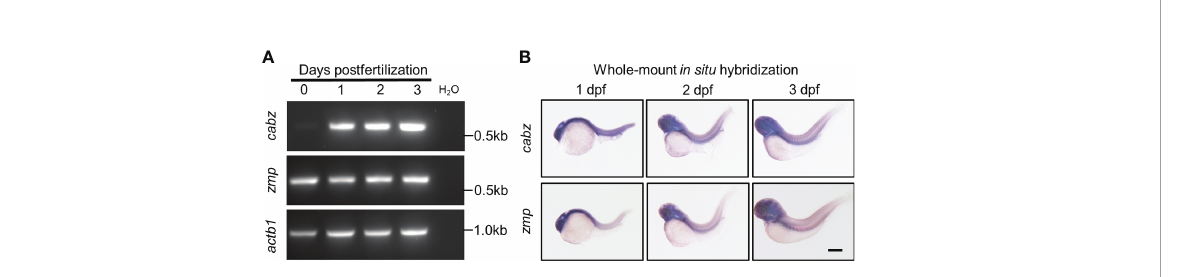
FIGURE 2 Developmental expression of putative zebra fi sh Il1r1 . (A) RT-PCR from WT embryos at 0-3 dpf showed expression of cabz beginning at 1 dpf, maternal expression of zmp at 0 dpf, and actin beta 1 ( actb1 ) transcript as an experimental control. Molecular weight markers are shown on the right. (B) Whole-mount in situ hybridization using antisense DIG-labeled riboprobes against cabz or zmp transcripts showed unrestricted expression of both transcripts at 1, 2, and 3 dpf. Scale bar in (B) is 200